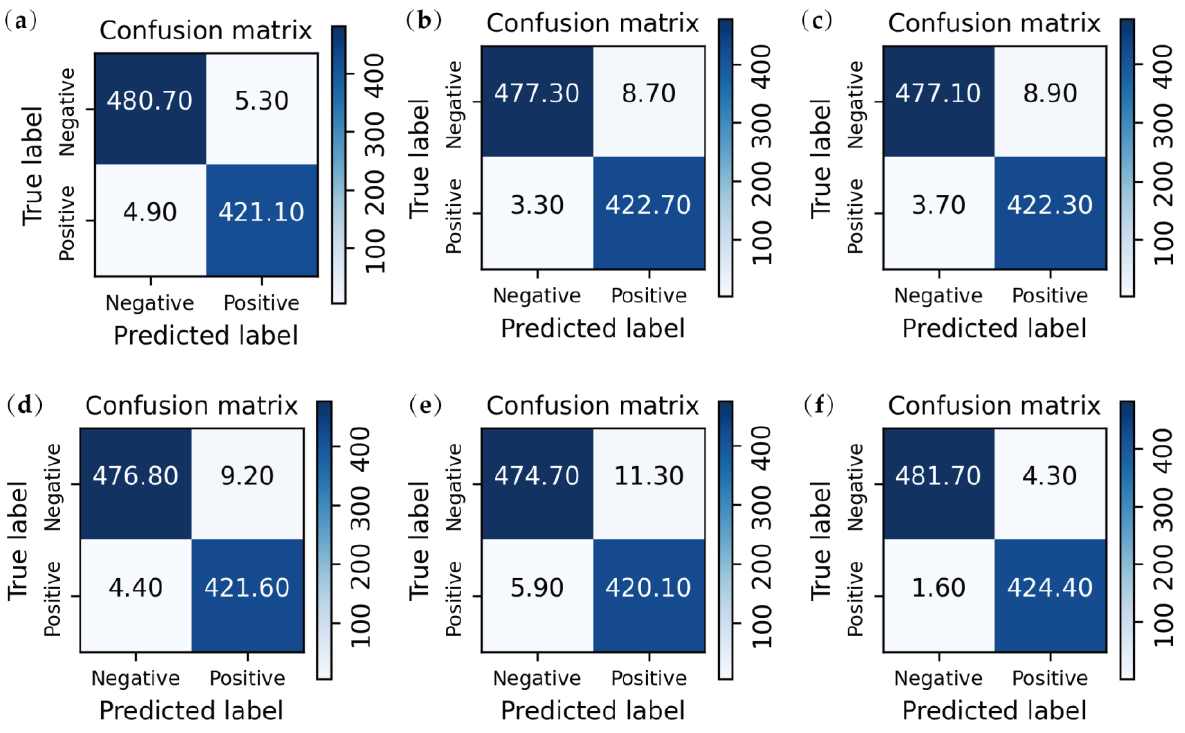
Figure 7. Average confusion matrix. Sub-figures ( a – f ) correspond to models 1–6 in Table 4, respectively.